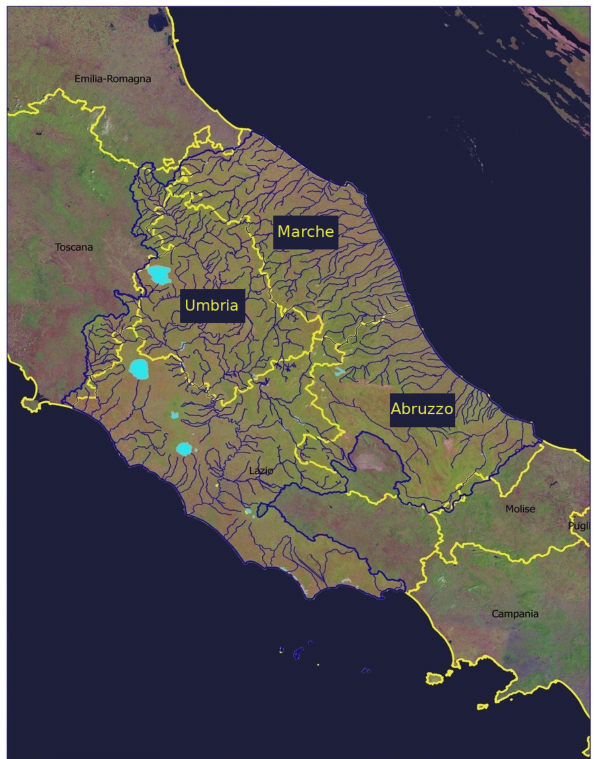
Figure 1. The Central Apennine Hydrological District (solid blue lines) and its main hydrography (thin blue lines). The north-eastern boundary is delimited by the Potenza river basin, while the south- eastern limit is represented by the Sangro basin in Abruzzo. The western side is delimited by the Tiber basin. Yellow lines indi- cate administrative boundaries of Italian regions. The three con- sidered regions are highlighted: Umbria, Marche, Abruzzo (cour- tesy of the Tiber Basin Authority, https://www.autoritadistrettoac. it/i-numeri-del-distretto, last access: 10 June